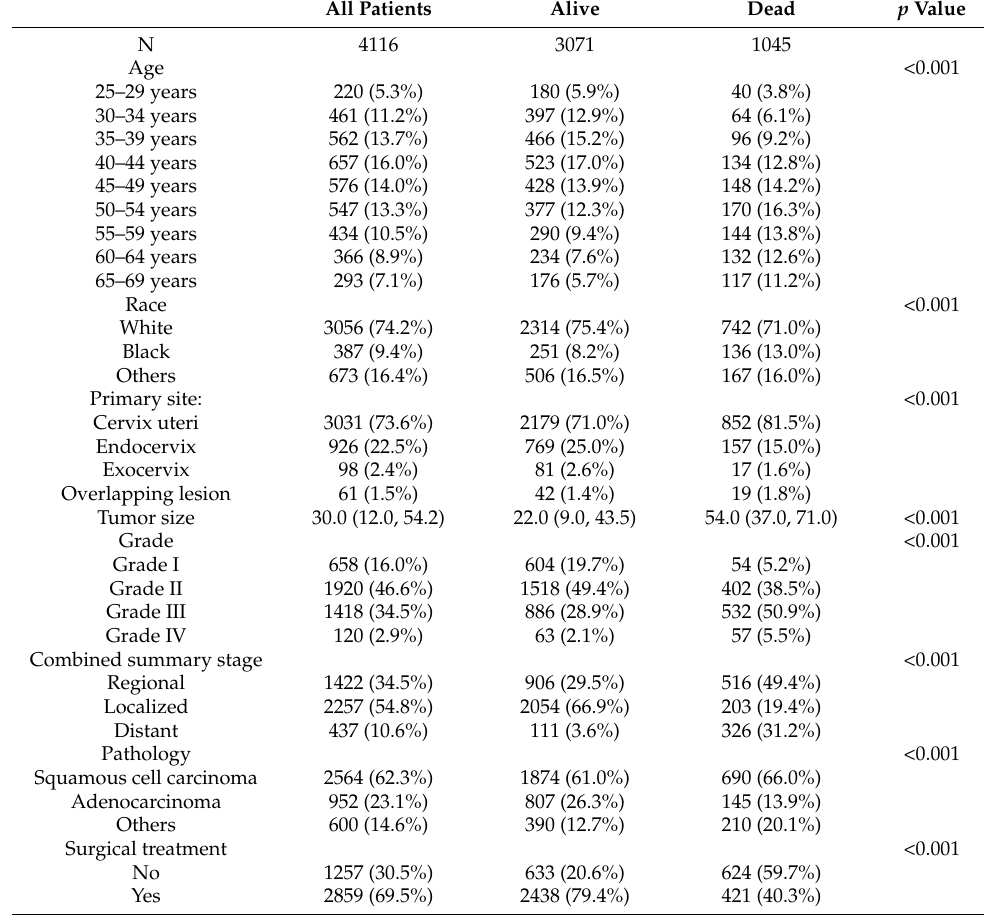
Table 1. Patients baseline